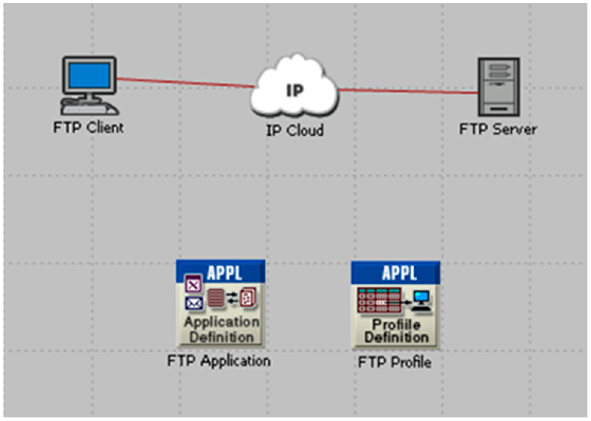
Figure 1. The Network